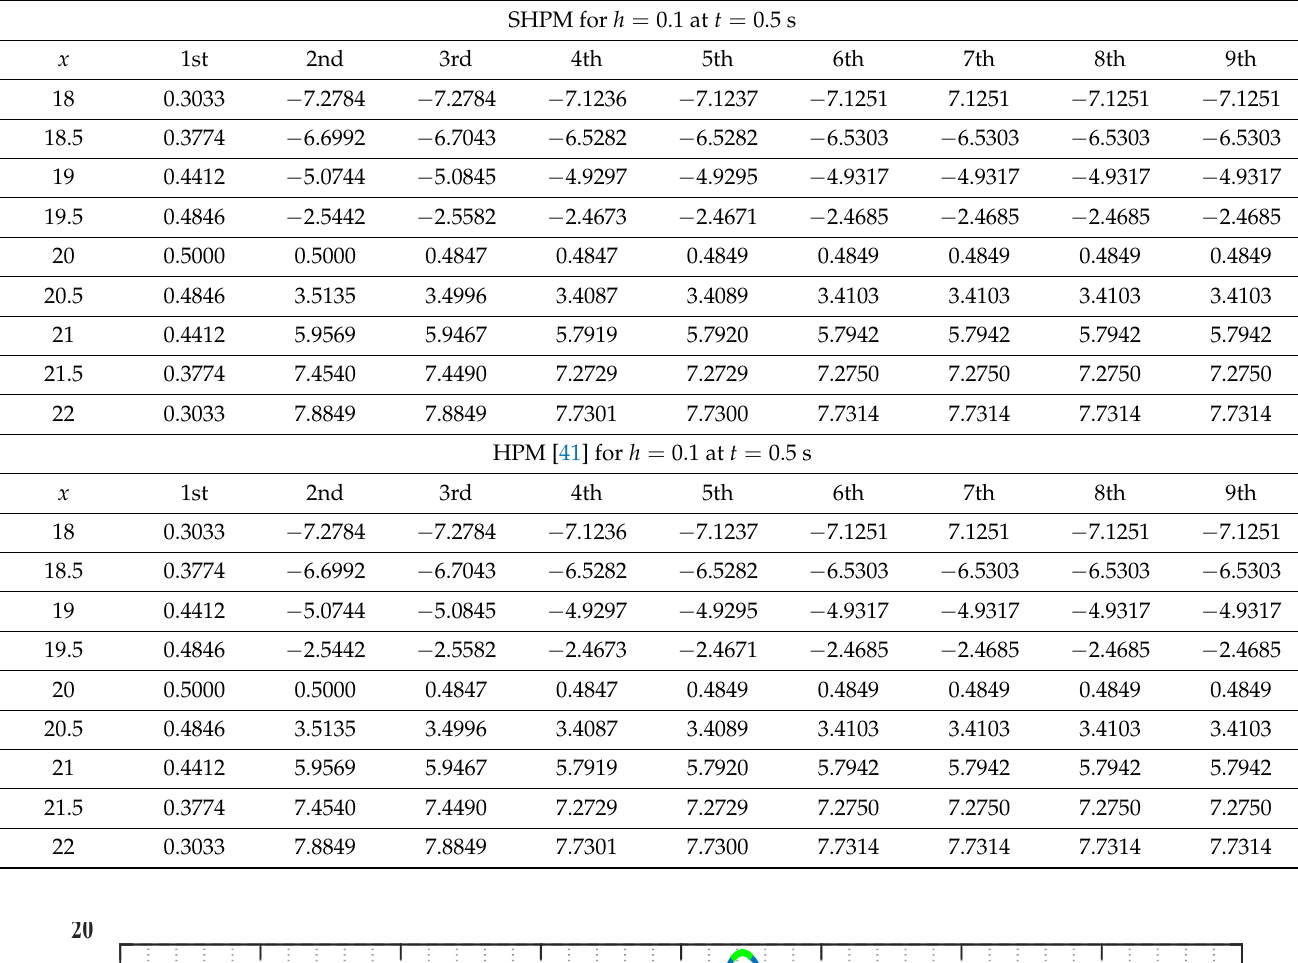
Table 4. Comparison table between SHPM and HPM.